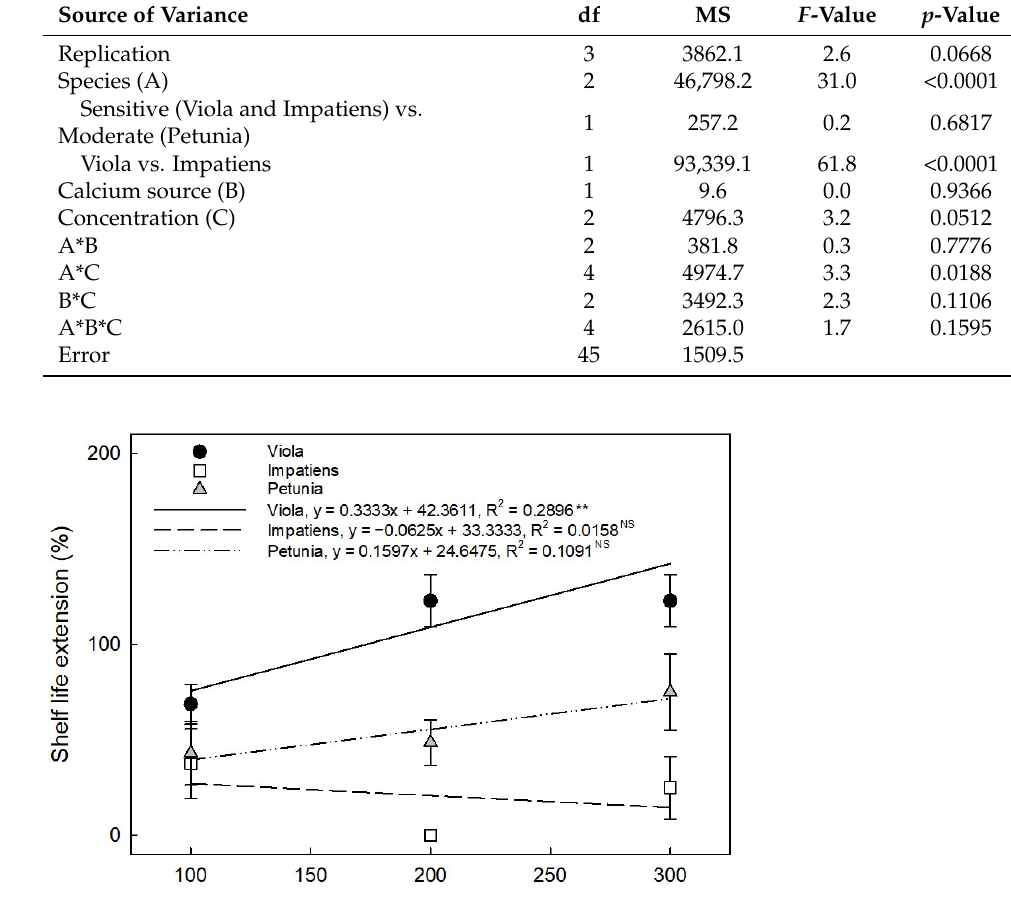
Table 2. Factorial ANOVA on shelf life extension in drench application.